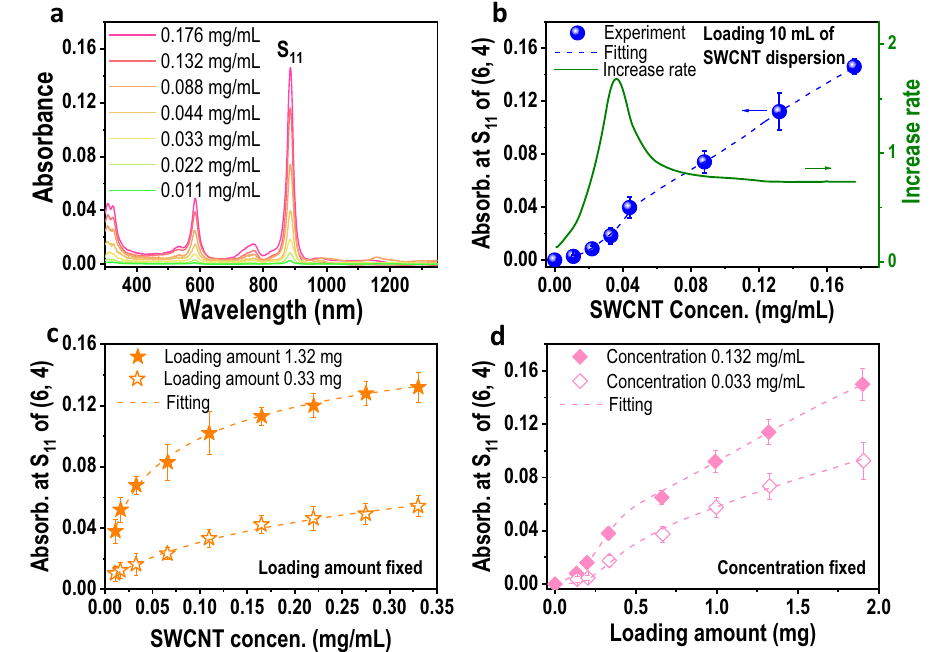
Fig. 5 | Effect of SWCNT concentration on the separation yield of (6,4) single- chirality SWCNTs. a Optical adsorption spectra of the separated (6, 4) species under different SWCNT concentrations with a fi xed volume of 20mL. b Plot of the absorbanceatS 11 of(6,4)asafunctionofSWCNTconcentration.Thegreencurveis the fi rst derivative of the relation curve between the concentration of the loaded raw materials and the yield of (6, 4) SWCNTs. c Relationship between the con- centration of individualized SWCNT concentration and the resulting yield of (6,4)